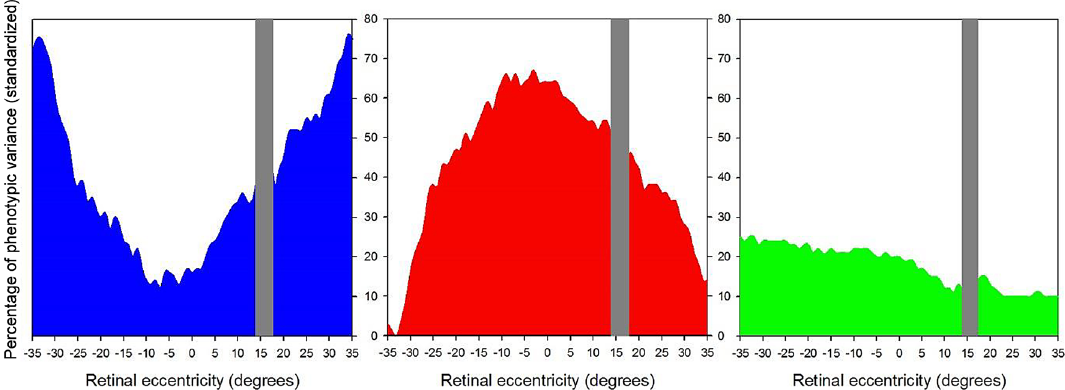
Figure 2. Percentage of phenotypical variance for variance components (ACE model) of objective refractive error, estimated by SEM analyses across the horizontal retina. 0° represent the position of the fovea; negative values indicate temporal retina, and positive values indicate nasal retina. Left: heritability (blue). Center: shared environment (red). Right: non-shared environment (green). The Grey area represents the area affected by the optic